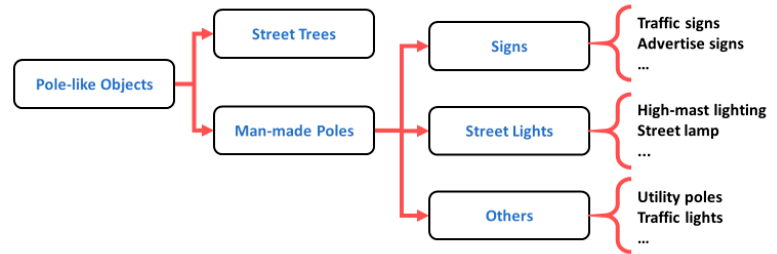
Figure 6. The hierarchical structure used for classifying pole-like objects.